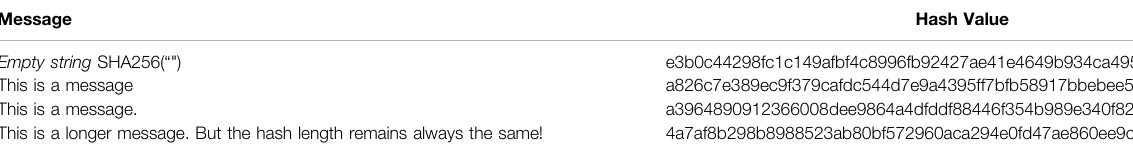
TABLE 1 | Examples of hash values generated by the SHA-256 hash algorithm. Message